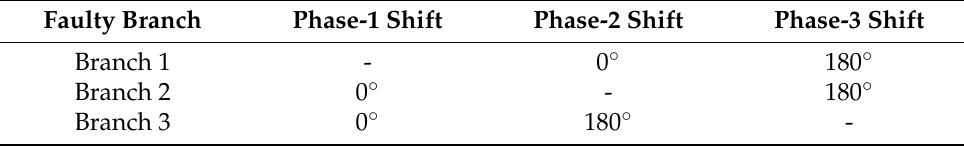
Table 1. Adjustment combinations of phase shift angles under different branch